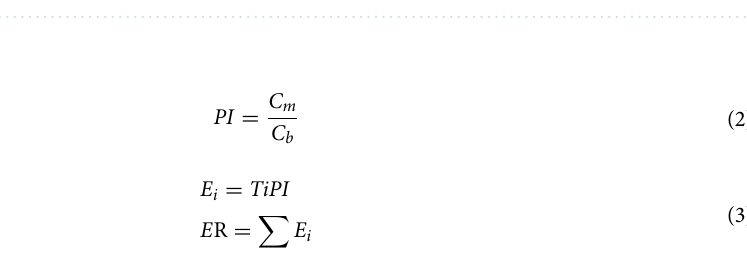
Table 1. Some environmental attibutes and soil classification of the current study. Moderatly deep, Deep, and Very deep: a depth of 50–80, 80–120, and more than 120 cm, respectively, *Symbols applied based on Soil Survey Staff